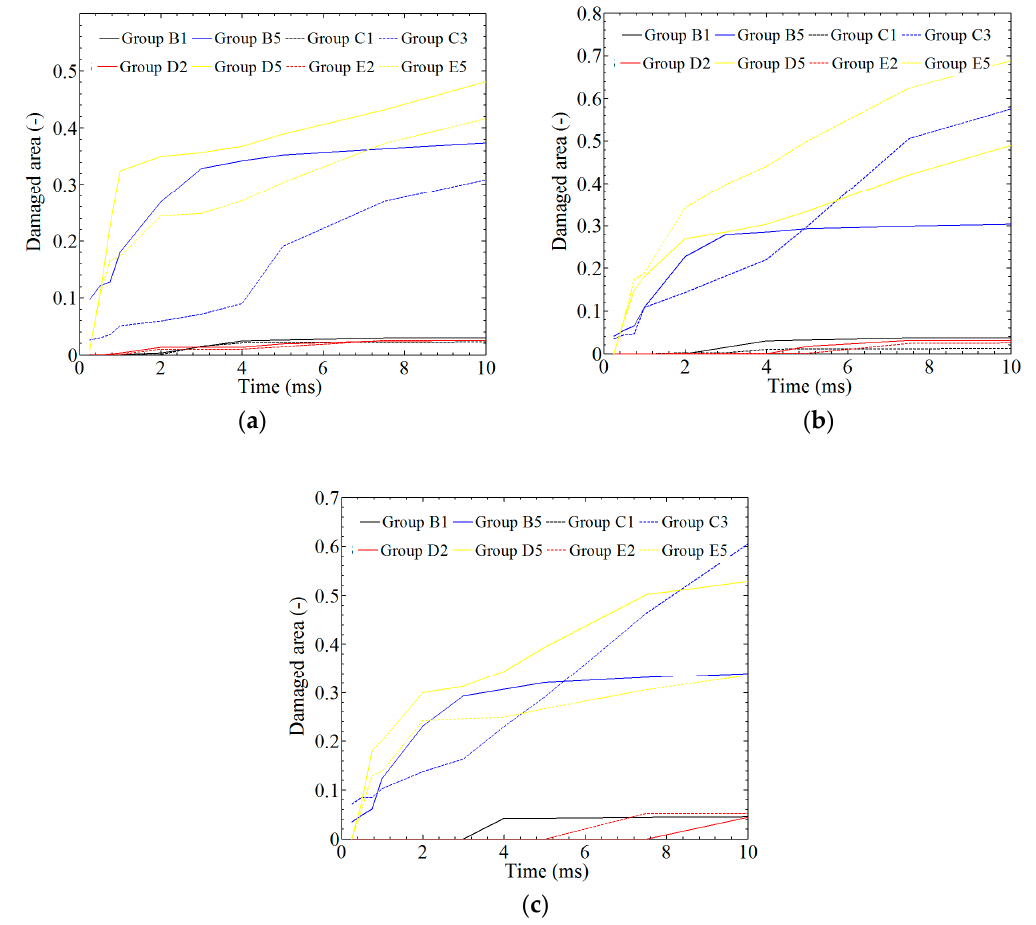
Figure 18. The statistics of the damage area in different groups: ( a ) layer 16; ( b ) layer 8; ( c ) layer 1.